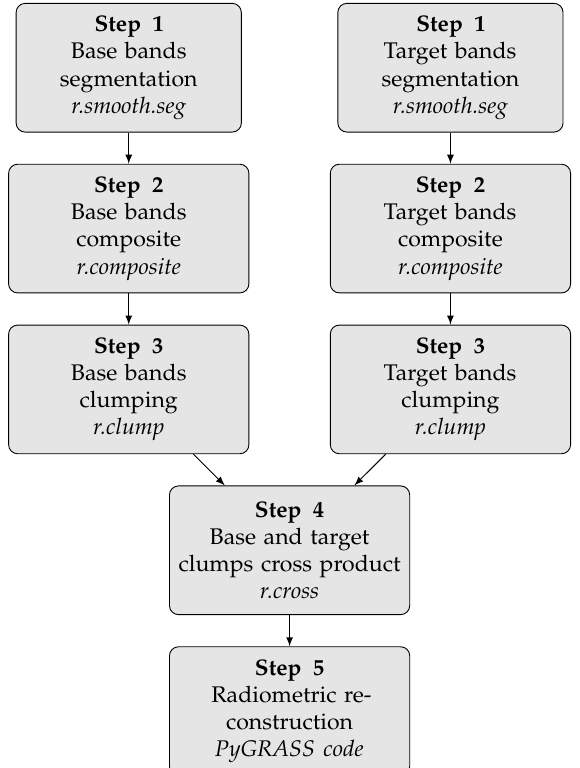
Figure 1. Flowchart of the proposed procedure for image reconstruction. Step 1 Mumford–Shah variational segmentation is applied to base and target imagery bands at hand. In this work, the processing was carried out on digital numbers. A unique mask of SLC-off stripes is used for the processing of target bands. The val- ues of model parameters α and λ are selected on an empirical base after a few test; when working with Landsat 7 and DNs, one can start with α = 500 and λ =